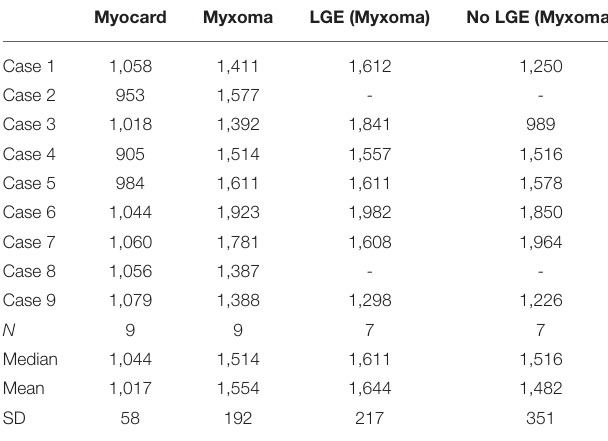
TABLE 4 | Extracellular volume (ECV) [%].